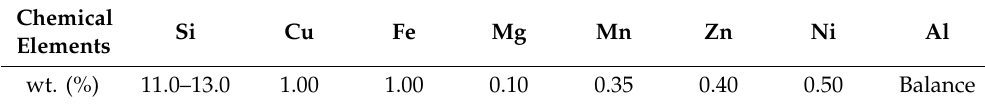
Table 1. Nominal chemical composition of AlSi12 (wt.%) [44].